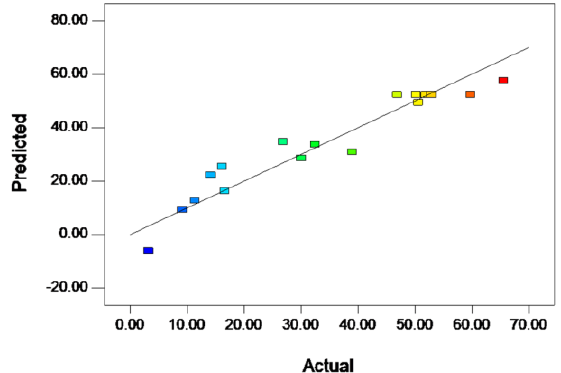
Figure 7. Actual values vs. predicted values.